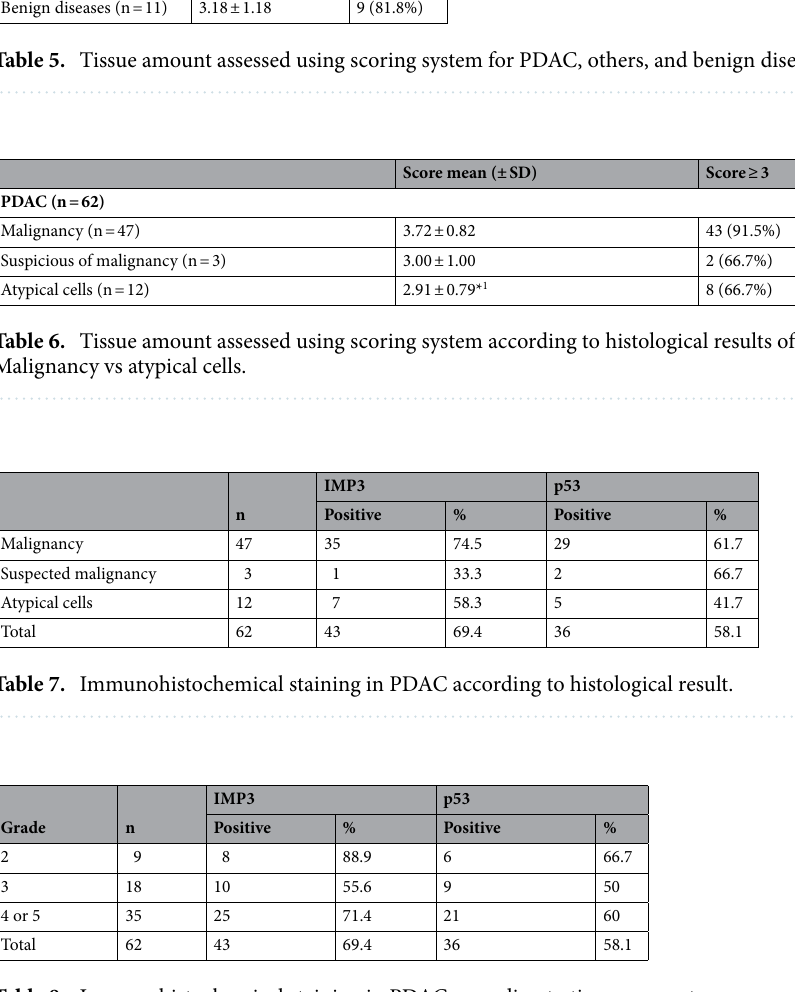
Table 8. Immunohistochemical staining in PDAC according to tissue amount.